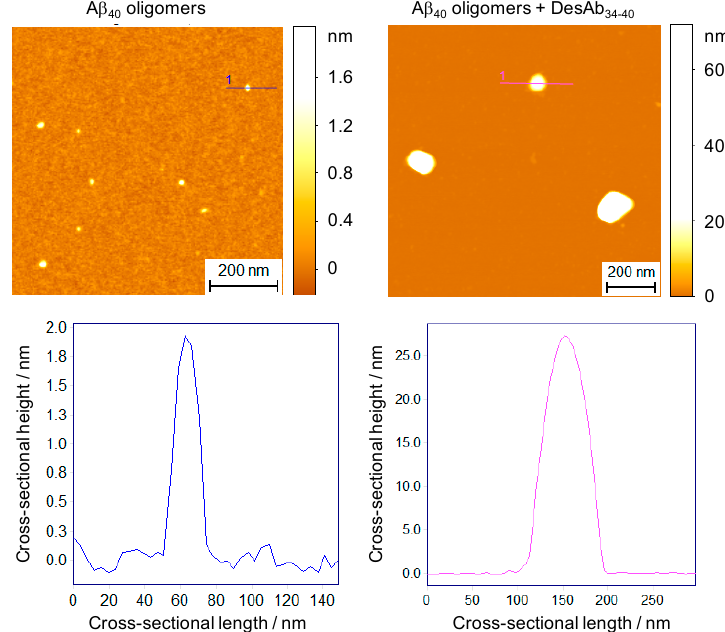
Figure 4. Phase-controlled AFM measurements of the oligomer-antibody complexes. A β 40 oligomers Figure 4. Phase ‐ controlled AFM measurements of the oligomer ‐ antibody complexes. A β 40 oligomers were incubated at a concentration of 10 µ M in the absence (left) and presence of 2 µ M DesAb 34-40 (right) were incubated at a concentration of 10 μ M in the absence (left) and presence of 2 μ M DesAb 34 ‐ 40 (right) and diluted 20 ‐ fold in buffer before deposition. Large oligomeric clusters (white aggregates in and diluted 20-fold in bu ff er before deposition. Large oligomeric clusters (white aggregates in the 3D the 3D AFM maps) were observed in the presence of DesAb 34 ‐ 40 . Representative aggregate heights are AFM maps) were observed in the presence of DesAb 34-40 . Representative aggregate heights are shown shown below each 3D color plot for the indicated cross ‐ sectional profiles. Scale bars, 0.2 μ m. below each 3D color plot for the indicated cross-sectional profiles. Scale bars, 0.2 µ